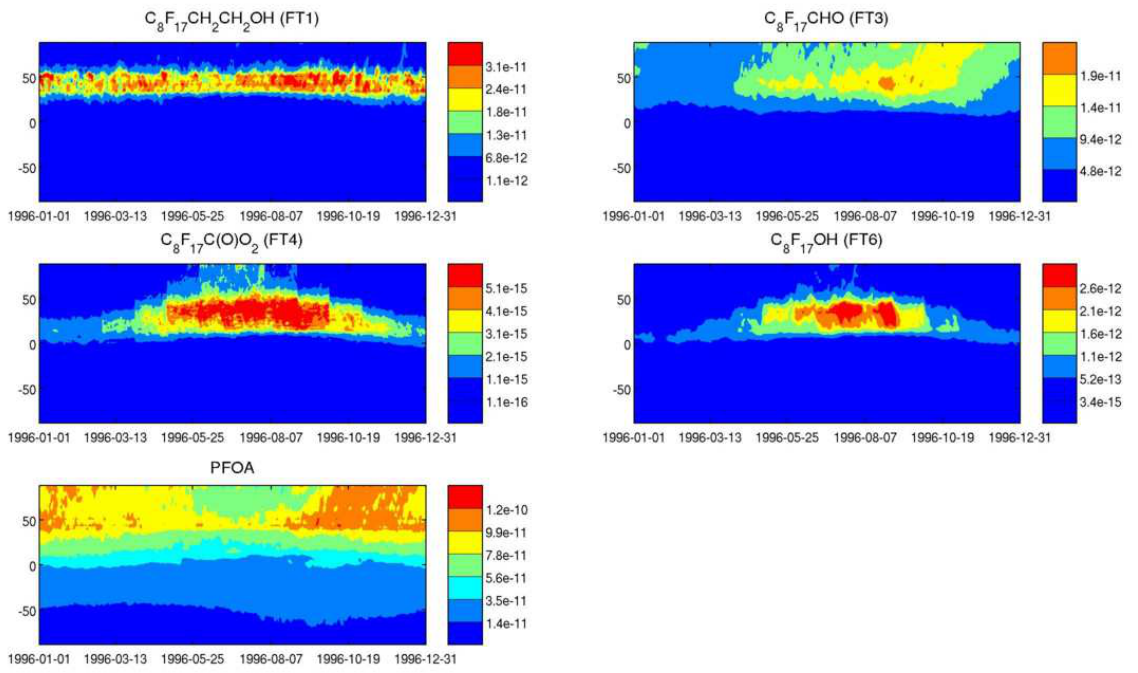
Fig. 5. One-year time series of the latitudinal distribution of daily 8:2 fluorotelomer alcohol (FT1), C 8 F 17 CHO (FT3), C 8 F 17 C ( O ) O 2 (FT4), C 8 F 17 OH (FT6), and PFOA atmospheric burdens [kgm − 2 ].